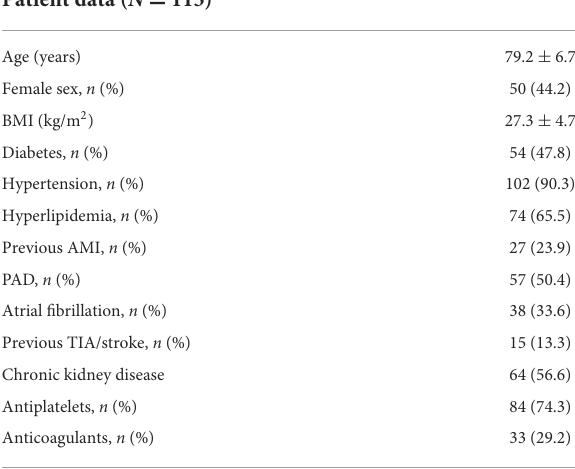
TABLE 2 Demographic parameters and cardiovascular risk